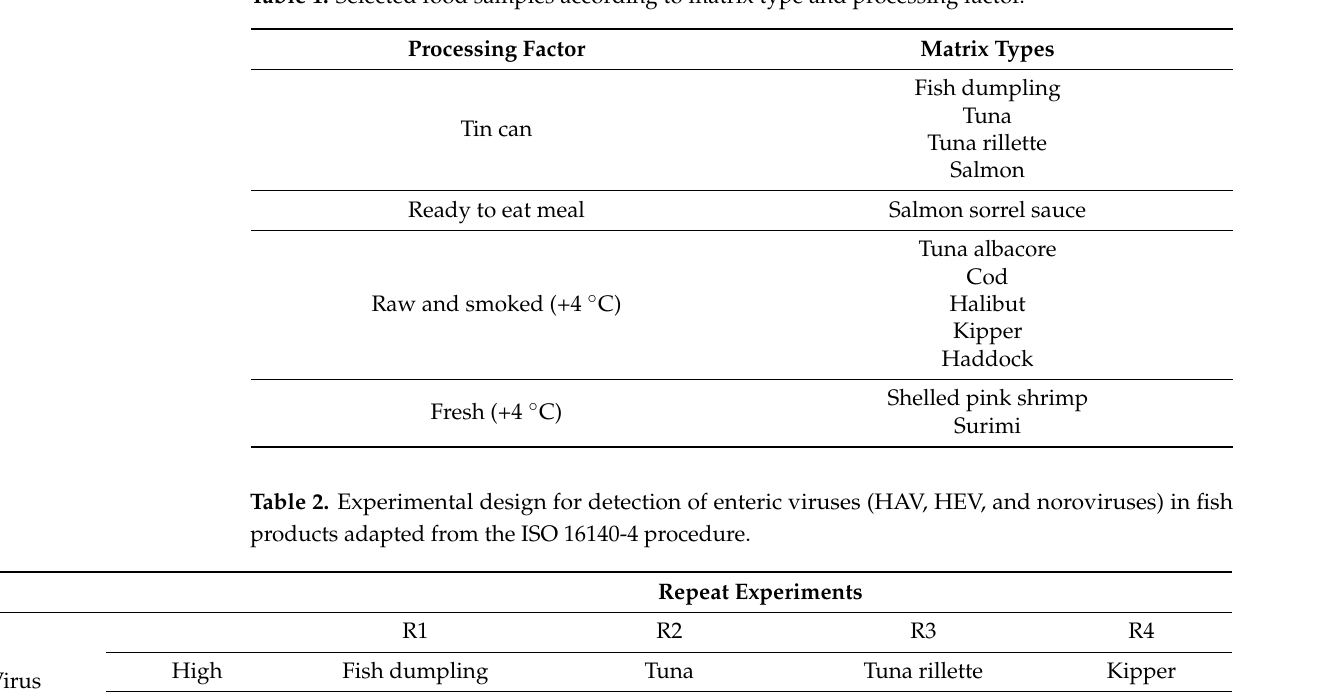
Table 1. Selected food samples according to matrix type and processing factor.